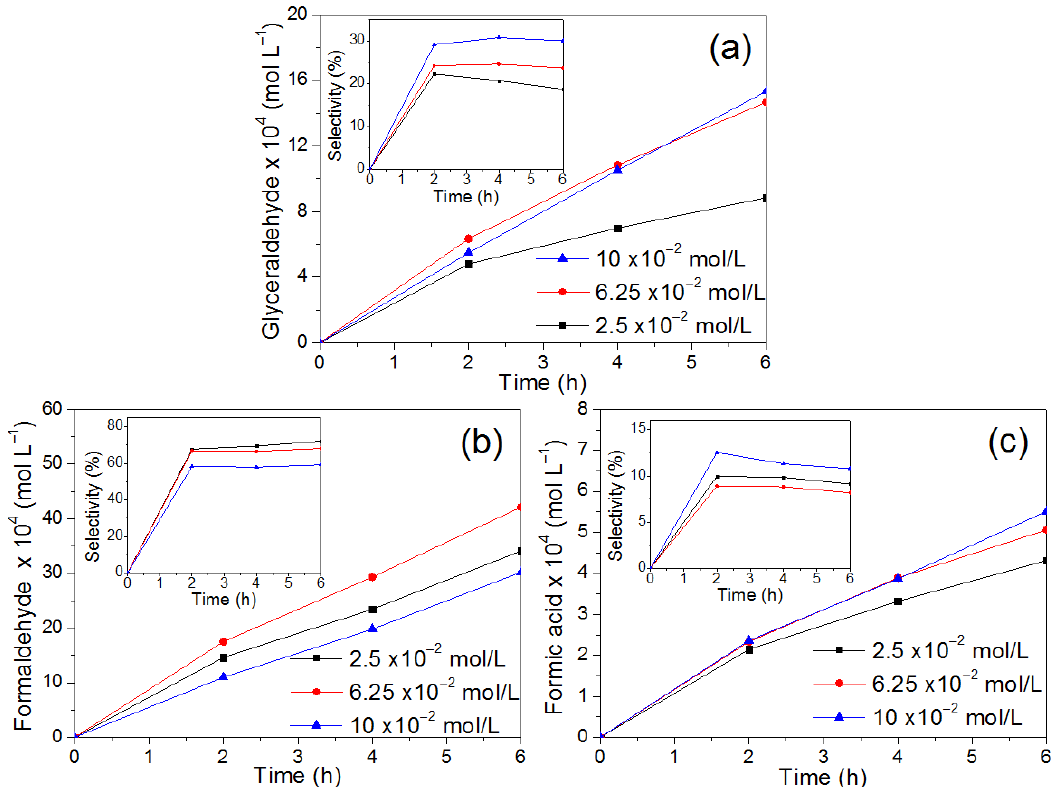
Figure 13. Effect of initial glycerol concentration on the selectivity and concentration of ( a ) glycer- aldehyde (GCD), ( b ) formaldehyde (FD), and ( c ) formic acid (FA). T = 305.65 K, Cu/TiO 2 = 0.25 g/L.